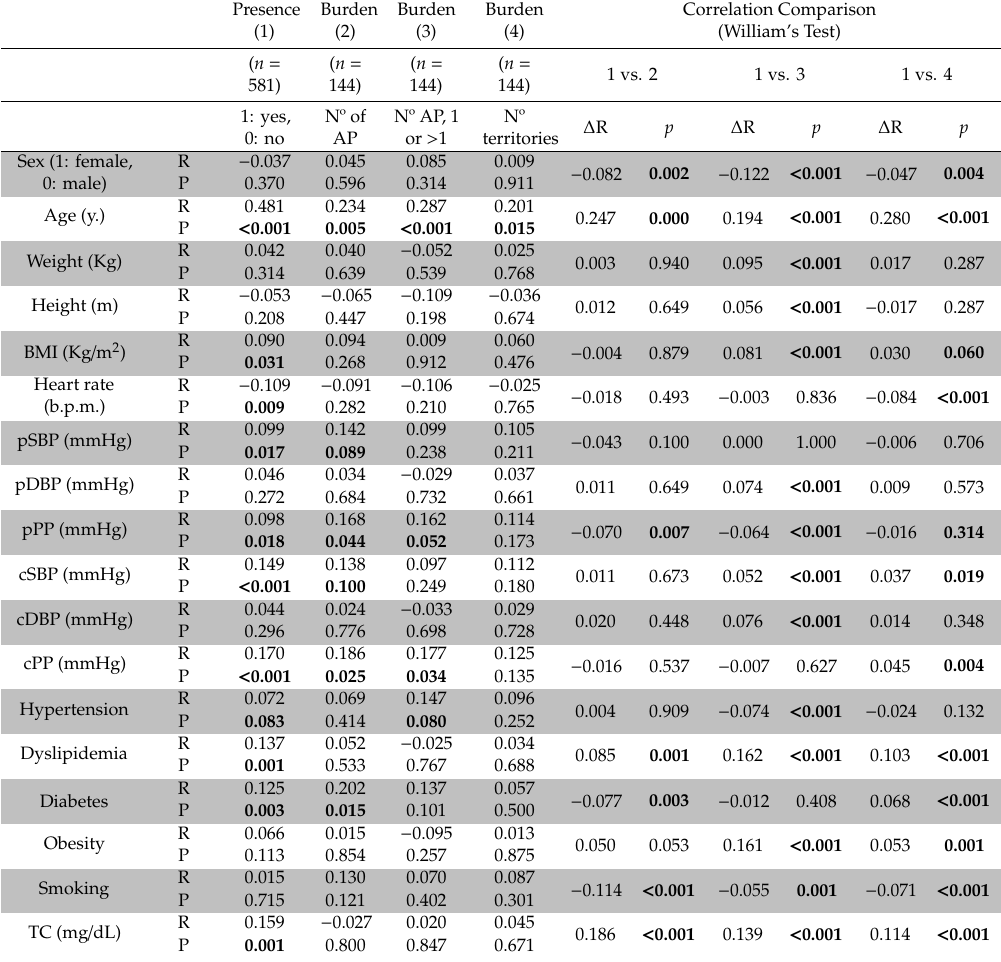
Table 2. Associations between subjects’ characteristics and plaques presence or burden: correlation comparison. Presence Burden (1)